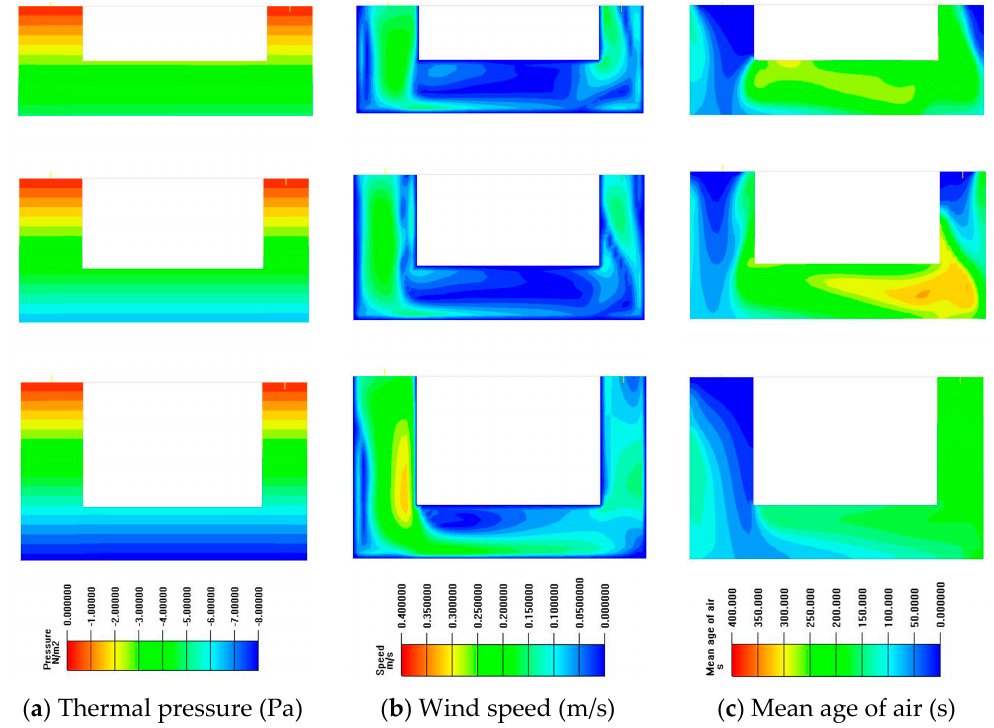
Figure 6. Comparison of different height of patio. ( a ) Thermal pressure; ( b ) Wind speed ( c ) Mean age of air.